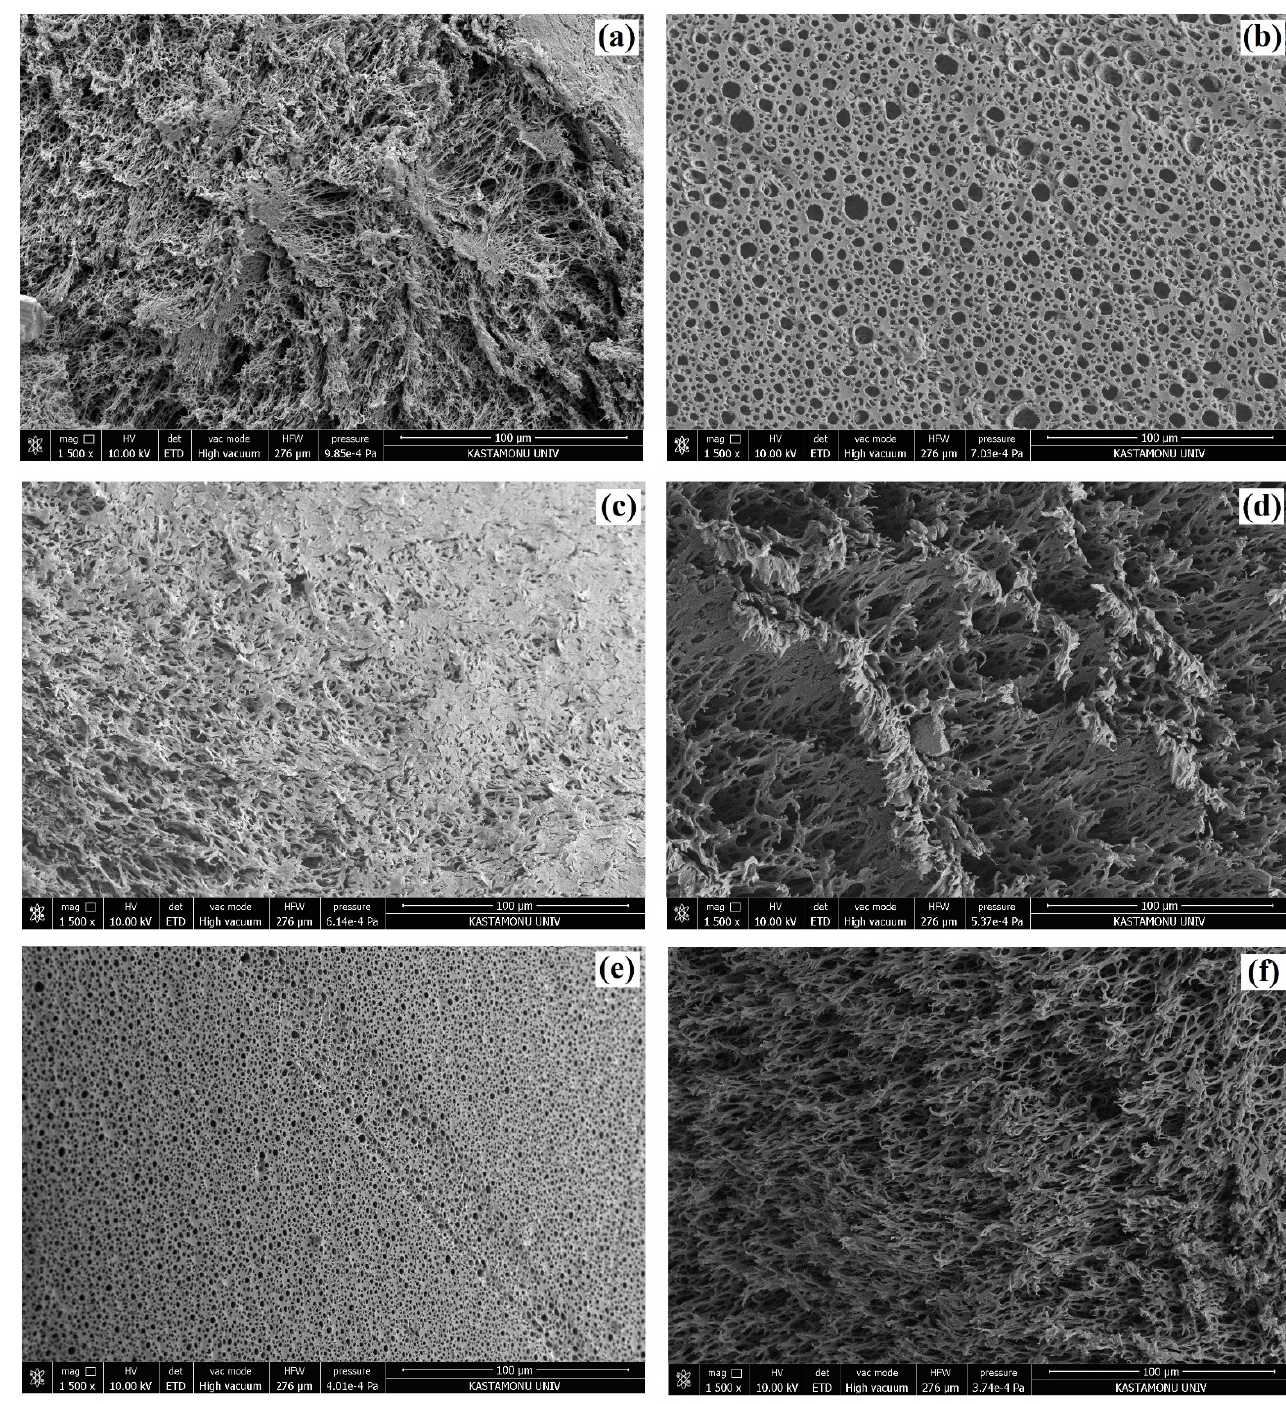
Figure 4. SEM images of polyDCPD composites: ( a ) 7-KP, ( b ) 8-KP, ( c ) 9-KP, ( d ) 10-KP, ( e ) 11-KP, and ( f ) 12-KP. Depending on the SEM images, it was calculated that the average cavity diameter (R1) of the polyDCPD composites varied between 3.91 μ m and 19.75 μ m, whereas the interconnecting pore diameters (R2) varied between 1.15 μ m and 5.82 μ m (Table 3). More- over, the average cavity diameters and interconnecting pore diameters of the control sam- ples (9KP, 10-KP, 11-KP, and 12-KP) were found to be in good agreement, which can be